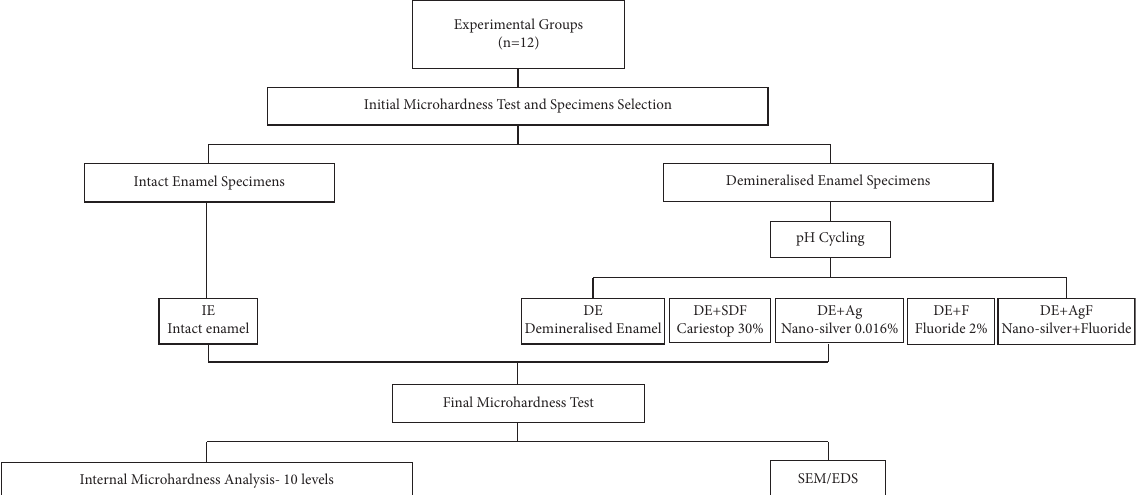
Figure 1: Flowchart of enamel remineralization analysis: scanning electron microscopy (SEM) and energy-dispersive X-ray spectroscopy